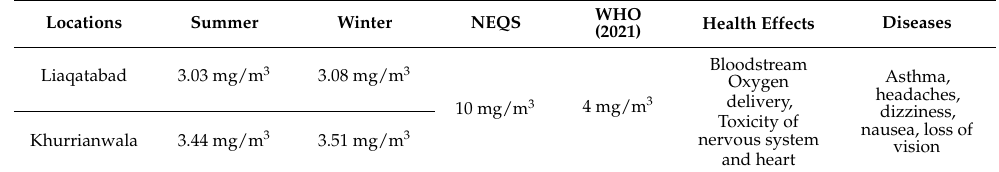
Table 3. Seasonal variation of CO at selected sites in comparison of NEQS and WHO and correspond- ing health effects.